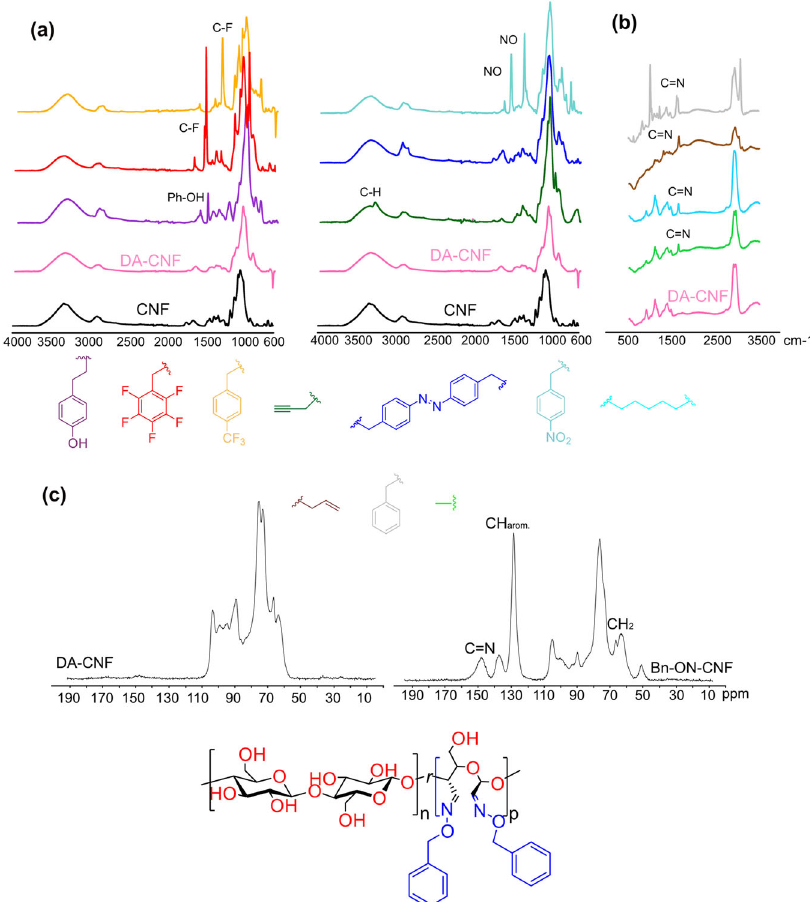
Fig. 4 | Characterization of R-ON-CNFs. a FTIR spectra of native (CNF), oxidized (DA-CNF), and modi fi ed (R-ON-CNF) fi lms containing the following substituents: phenol (purple), penta fl uorobenzyl (red), p -CF 3 benzyl (orange), propargyl (dark green), azobenzyl (blue), p -NO 2 benzyl (turquoise), pentyl (light blue), allyl